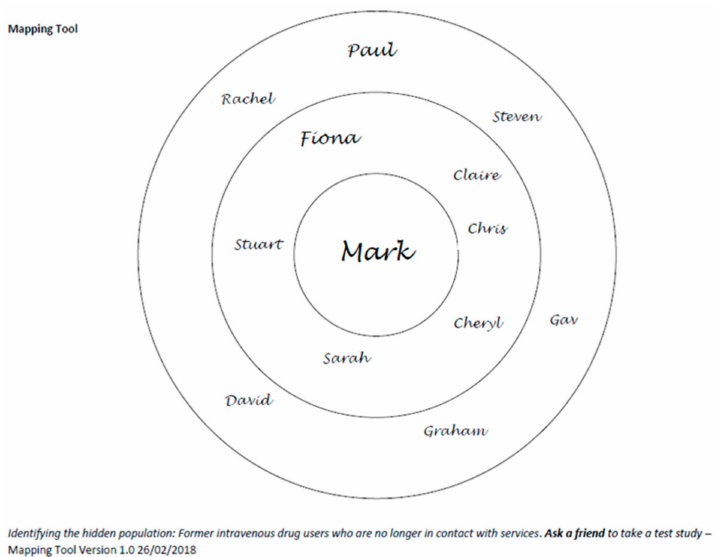
Figure 1. Social network mapping tool example. The participants name is placed in the centre, the inner circle represents individuals with whom the participant has a close relationship with and/or is in contact with on a regular basis. The outer circle represents individuals the participant regards as being within their social network but that they are in contact less frequently and/or are considered to be acquaintances rather than